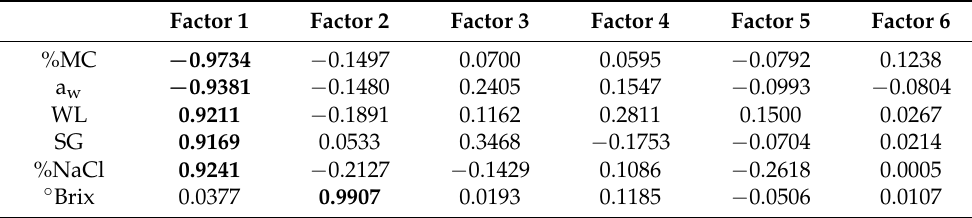
Table 1. Factor coordinates of the variables, based on correlations (all). Numbers in bold depict a strong